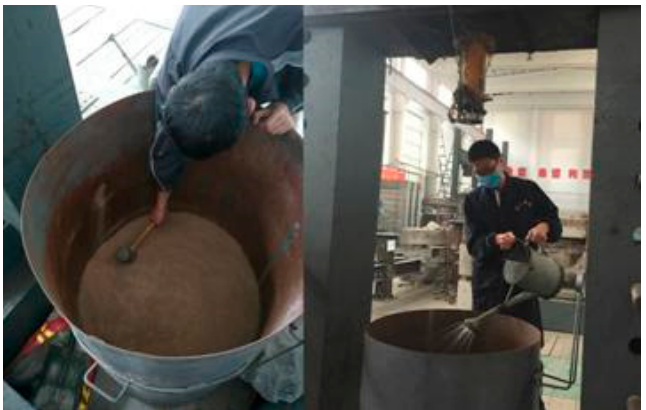
Figure 7. Working process for the model foundation.